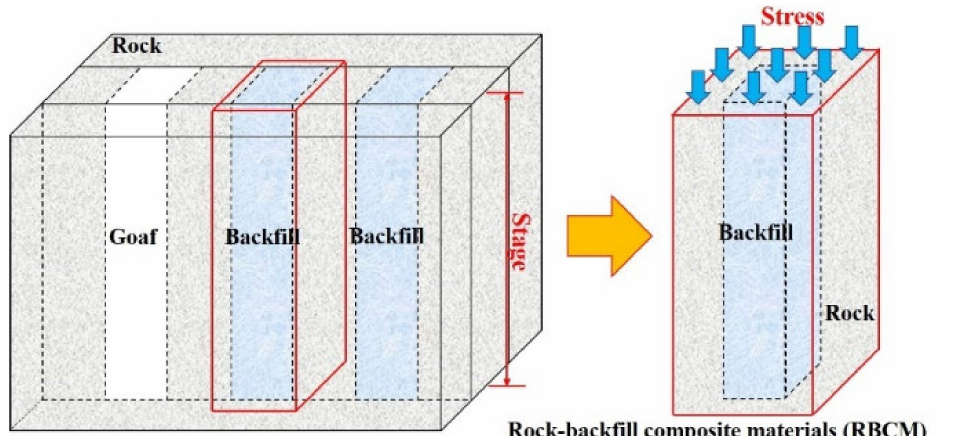
Figure 1. Field model of rock–backfill composite